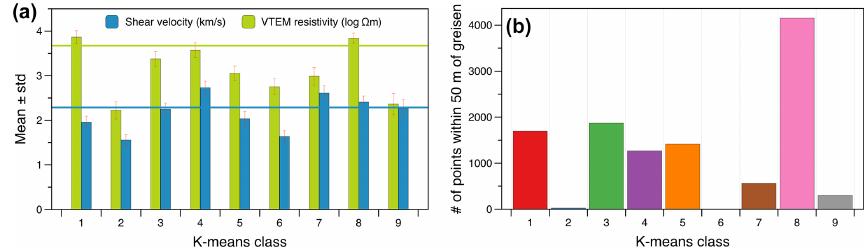
Figure 13. Classification statistics showing (a) per-class mean values of shear velocity and VTEM resistivity and (b) number of points per class within a 50m radius of individual greisen occurrences. The horizontal lines in (a) correspond to the mean shear velocities and resistivities extracted from the block model, which are calculated using a buffer of 5, 10, 50 and 100m around drilled greisen occurrences.